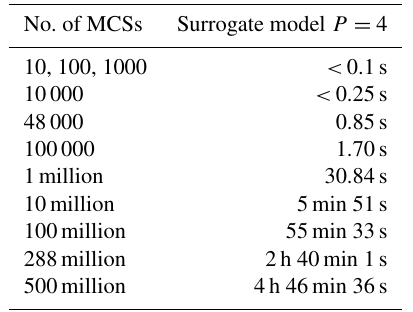
Figure 11. Maximum load and percentile comparison between the aerodynamic simulation reference case, the MCSs, and group aero- dynamic simulations for